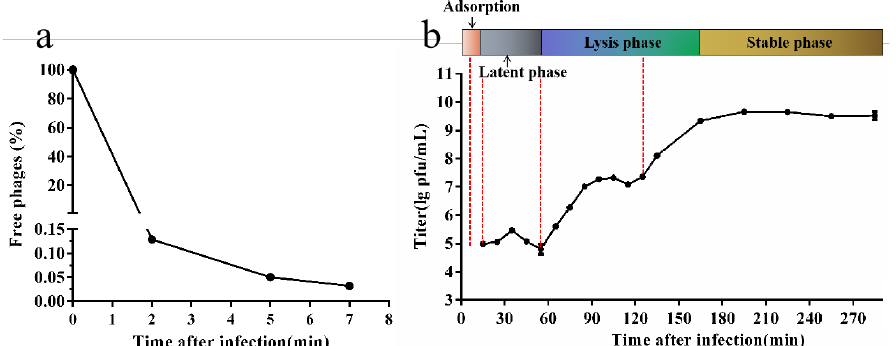
Figure 1. The life-cycle of phage SA1 against S. lentus JTB1-3. ( a ) Adsorption curve of SA1 to its host S. lentus JTB1-3. Free phage (%) = the number of free phages after infection/the number of free phages without infection. After incubation for 5 min, free phages accounted for only 0.05% of phages in total. ( b ) One-step growth curve of phage SA1 after incubation for 5 min. The data are expressed as means ± SD (n = 3). Table 1. Alignment statistics of clean reads mapped to reference genome/gene sequences. Map to